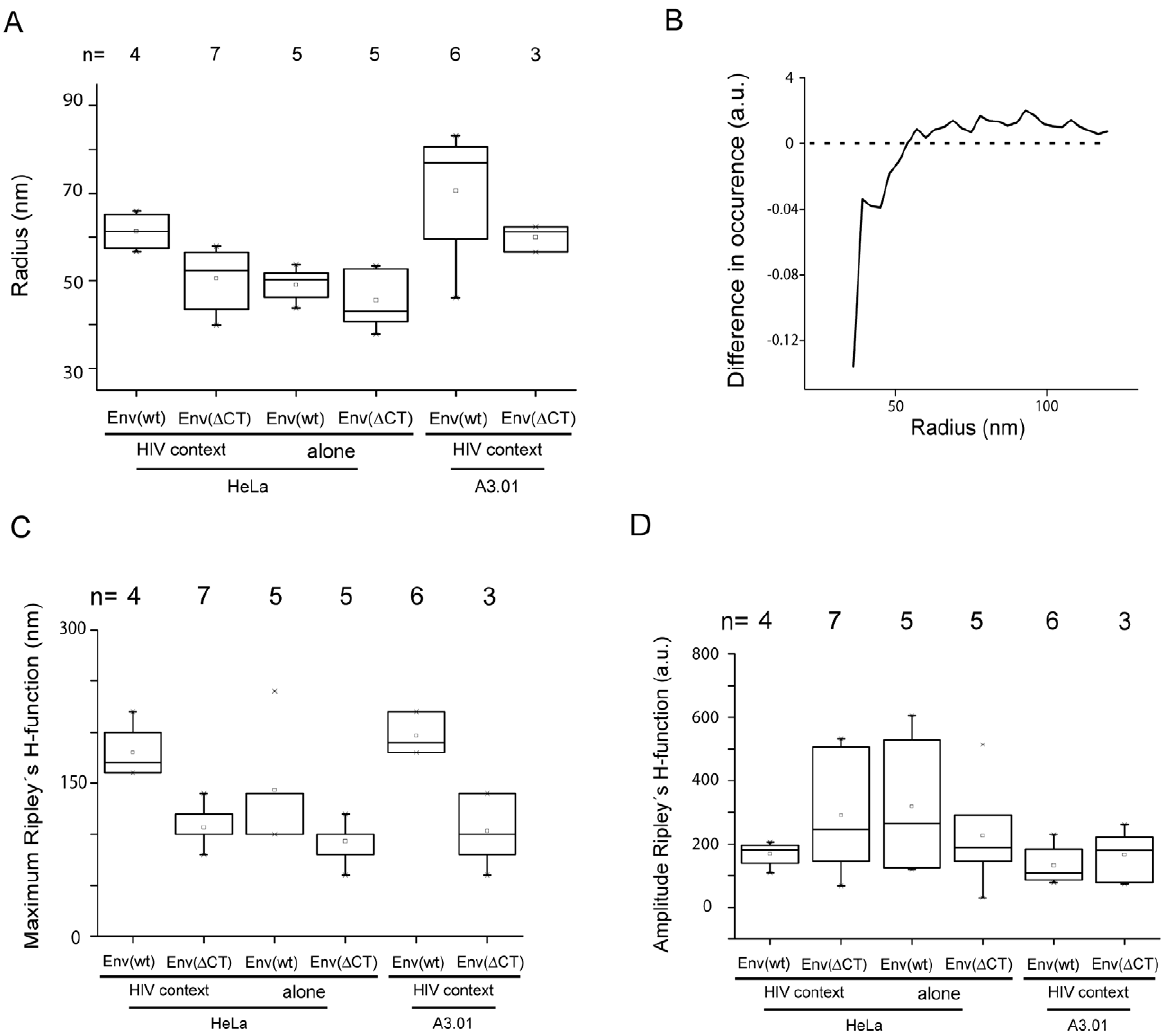
Figure 6. Computational cluster analysis of HIV-1 Env membrane distribution. Global cluster analysis of Env distribution at the plasma membrane was performed based on super-resolution images of HeLa cells transfected with pCHIV/pCHIV mEos.FP , pCHIV. Env( D CT)/pCHIV mEosFP Env( D CT), pEnv(wt) or pEnv( D CT), or of A3.01 T-cells nucleofected with pCHIV/pCHIV mEos.FP or pCHIV.Env( D CT)/pCHIV mEosFP Env( D CT), respectively. ( A ) Image- based,morphological cluster analysis of entire cells. ( B ) Differential distribution of cluster size forEnv(wt) on the surface of HeLa cells in the presence and absence of other viral proteins. The curve was derived by subtraction of the normalized distribution of cluster size obtained by image-based cluster analysis for Env(wt) expressed in the HIV-1 context from that obtained upon expression of Env(wt) alone. ( C ) Coordinate based all-distance distribution analysis by Ripley’s H-function. Statistical evaluation of the maximal H-values [nm] was performed as a correlate of the average cluster diameter. ( D ) Statistical evaluation of the amplitude of the H-function [a.u.] as a measure of the average degree of clustering. Box plots display 5 th percentile, 25 th percentile, median (straight line), mean (square), 75 th percentile and 95 th percentile.